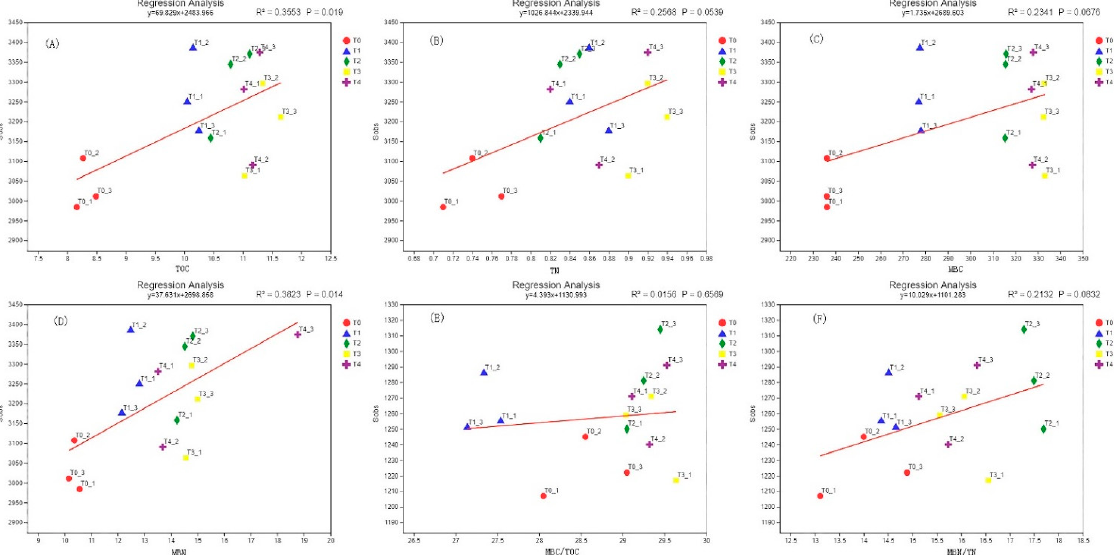
Figure 6. Regression analysis of bacterial ranking. The X-axis is the environmental factor, the Y-axis is the α -diversity ranking axis, R 2 is the coefficient of determination, which represents the proportion of variation explained by the regression line. The larger the R 2 , which indicates that the environmental factor shows differences in the community composition or α -diversity of the sample on the ranking axis, the higher is the degree of explanation of the difference in the diversity index. ( A ) The environmental factor is total organic carbon (TOC); ( B ) the environmental factor is microbial biomass carbon (MBC); ( C ) the environmental factor is TN (total nitrogen); ( D ) the environmental factor is microbial biomass nitrogen (MBN). ( E ) the environmental factor is MBC/TOC. ( F ) the envi- ronmental factor is MBN/TN.